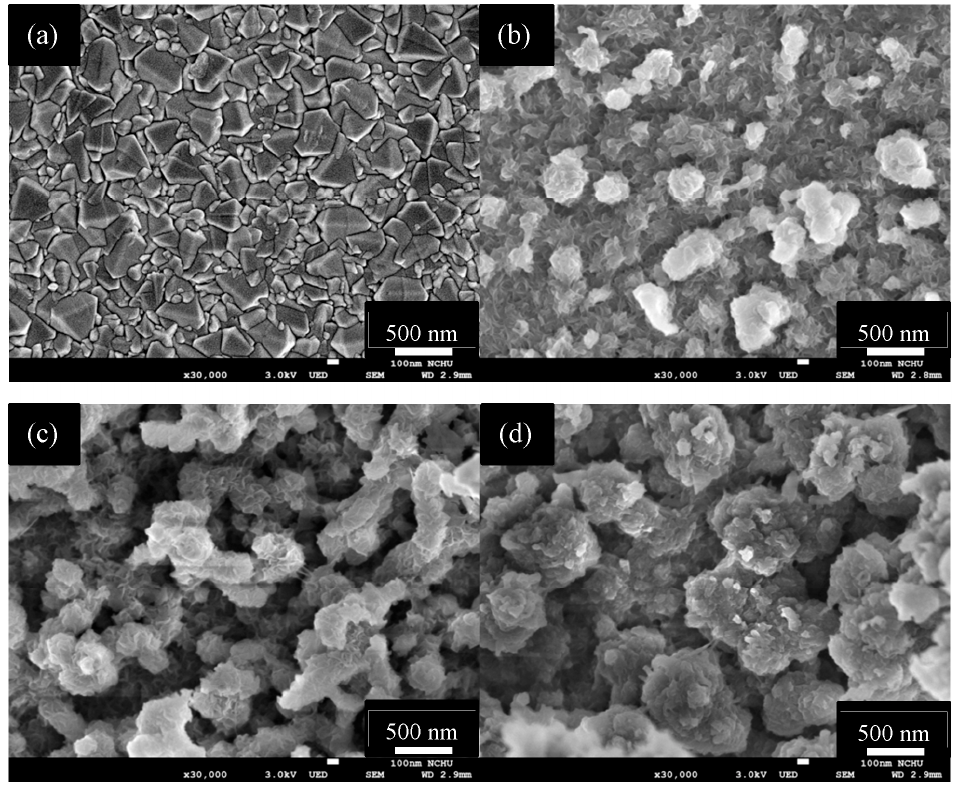
Figure 2. SEM images of the ( a ) 30 s Pt–FTO; ( b ) 0.025 C/cm 2 PProDOT-Bz 2 /30 s Pt–FTO; ( c ) 0.05 C/cm 2 PProDOT-Bz 2 /30 s Pt–FTO; ( d ) 0.1 C/cm 2 PProDOT-Bz 2 /30 s Pt-FTO.